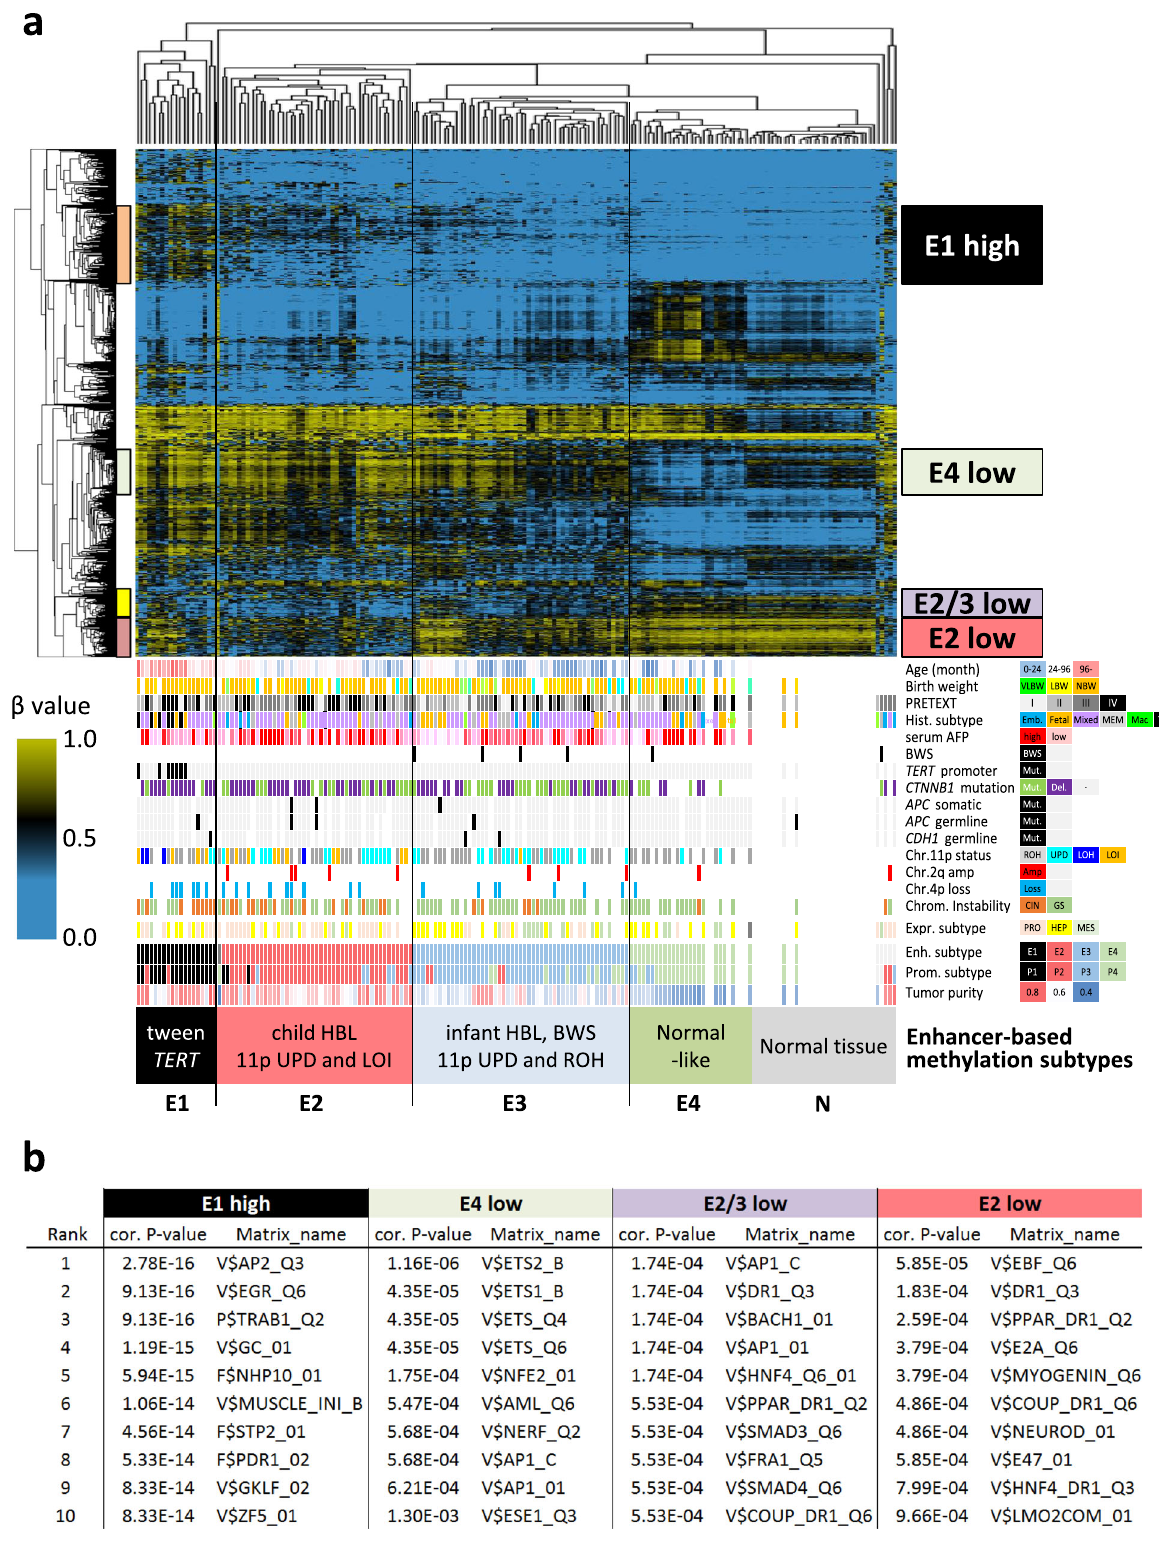
Fig. 4 Enhancer methylation subtypes and aberrant hypomethylation in hepatoblastoma. Unsupervised clustering of 146 childhood hepatoblastoma (HB) and 11 non-cancerous livers using the most variably methylated CpGs located at the enhancer regions of adult and fetal livers. The heat map shows the methylation level of each tumor (horizontal axis) plotted by the probe sets (vertical axis) in the top panel. The bottom panel shows clinical and pathological parameters, molecularly de fi ned subtypes of HB patients. Statistical signi fi cance was analyzed using Fisher ’ s exact test (* p < 0.01). b Signi fi cant motifs of transcription factors most strongly enriched in the subtype-speci fi c hyper/hypomethylated probe sets using the TRAP (Transcription factor Af fi nity Prediction Web Tools). The matrix entries have an identi fi er that indicates one of the six groups of biological species (V$ vertebrates, I$ insects, P$ plants, F$ fungi, N$ nematodes, B$ bacteria). The P -value for each sequence was combined using the two-sided Fisher ’ s method and corrected for multiple testing. NATURE COMMUNICATIONS| (2021) 12:5423